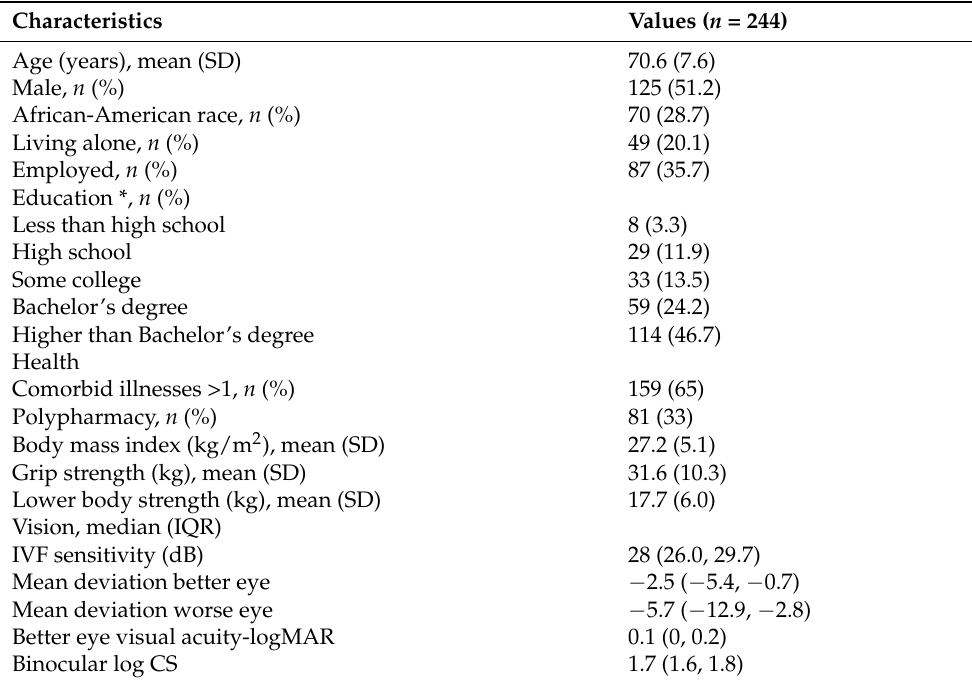
Table 1. Study population characteristics at